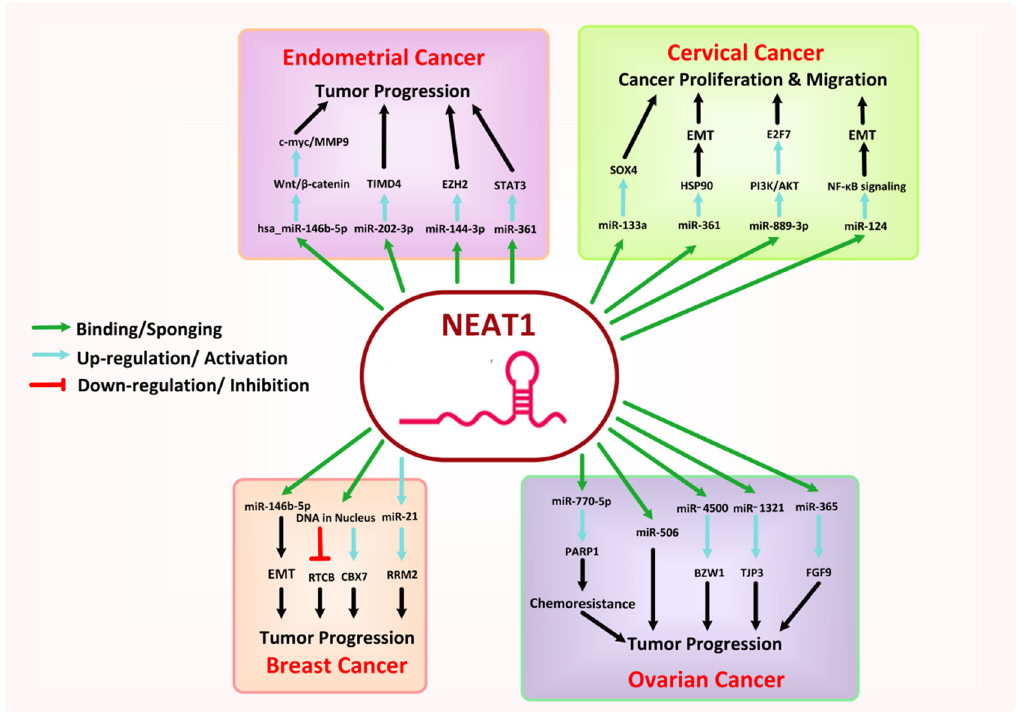
Figure 5. Mechanism associated with the oncogenic role of NEAT1 in female-oriented cancers.